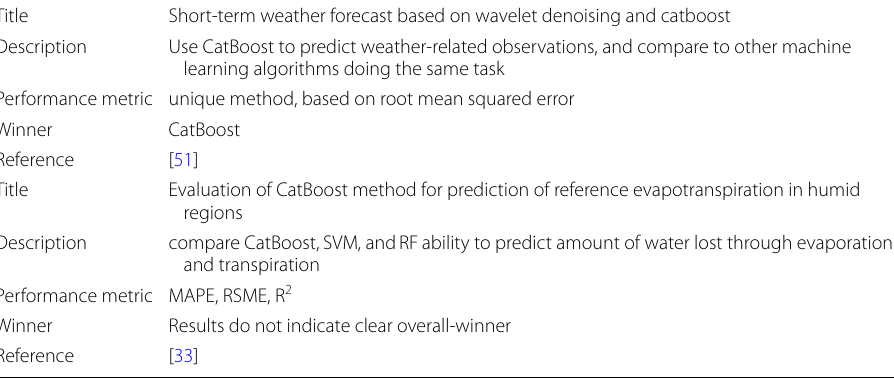
Short-term weather forecast based on wavelet denoising and catboost